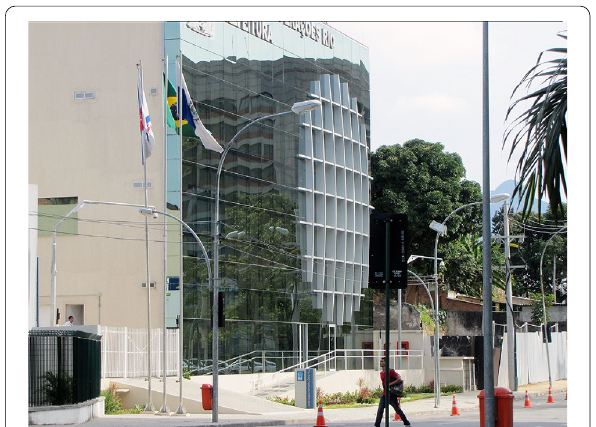
Fig. 2 Photograph of COR in Rio de Janeiro